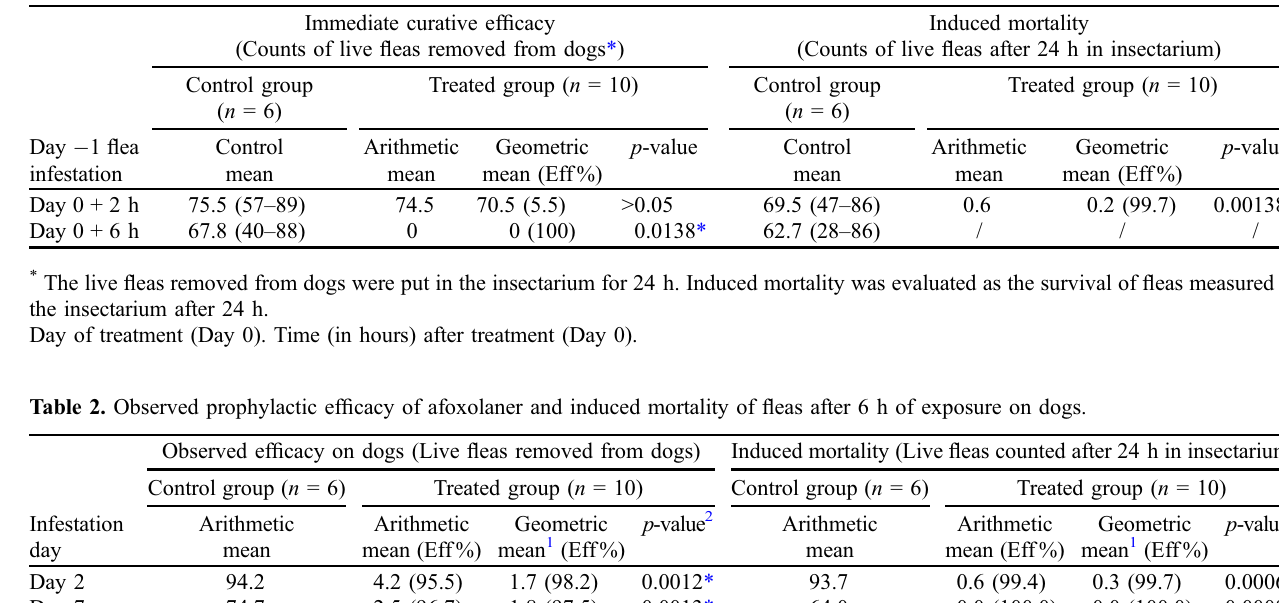
Table 1. Immediate efficacy and induced mortality of afoxolaner against fleas after 2 h or 6 h of exposure on dogs. Immediate curative efficacy (Counts of live fleas removed from dogs*)